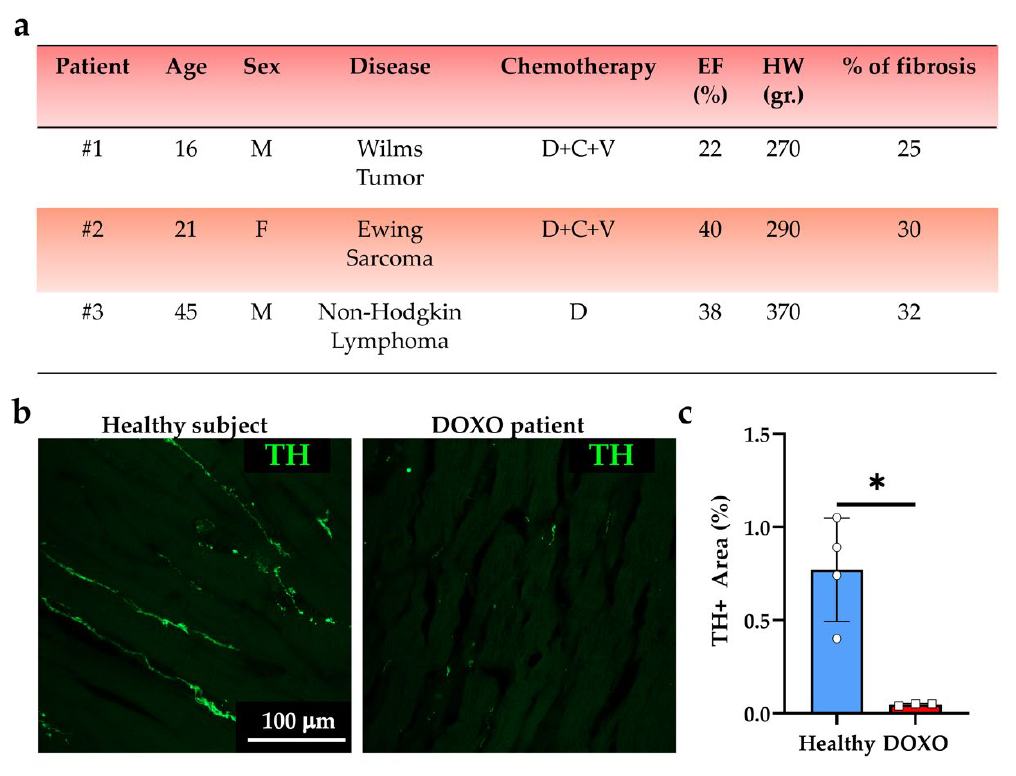
Figure 7. Patients receiving DOXO treatment show cardiac sympathetic denervation. ( a ) Character- istics of patients that were analyzed in the study. D, DOXO; C, cytarabine; V, vincristine. The percentage of fibrosis was calculated as described in the Methods section. Heart weight was assessed at the time of explant. ( b ) Confocal immunofluorescence on human heart sections from the mid-portion of the LV in healthy vs. DOXO-treated hearts. Sections were stained with an antibody to tyrosine hydroxylase (TH). The images were used to quantify the percentage of myocardial area that was occupied by TH-positive (TH+) fibers ( c ). Bars represent s.d. Differences among groups were determined using unpaired t -test with Welch’s correction. (Four (Ctrl) and three (DOXO) in- dependently processed heart slices from three different hearts/groups were analyzed; *, p < 0.05).